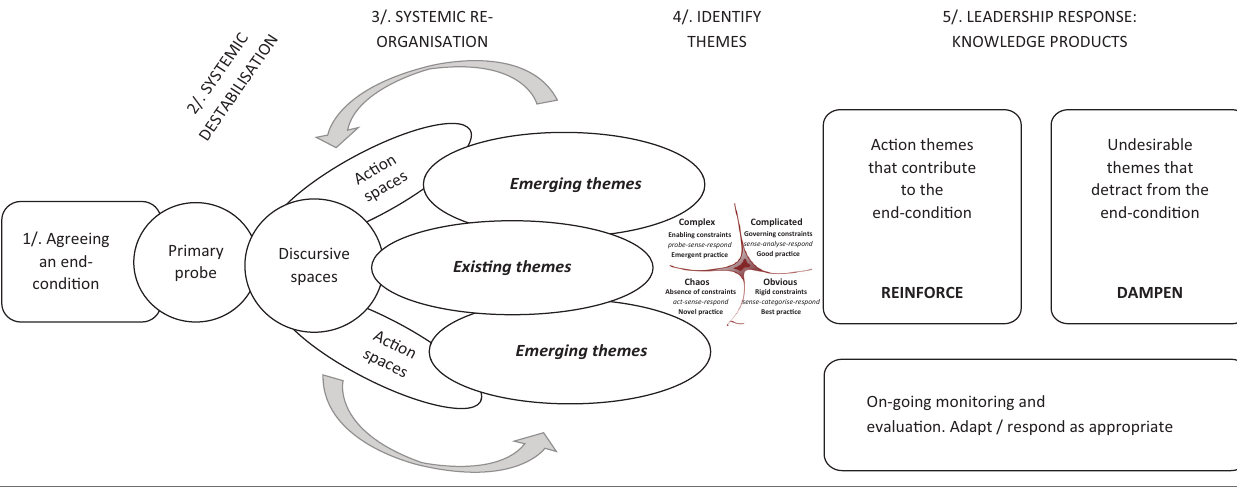
FIGURE 4: The Taming Wicked Problems